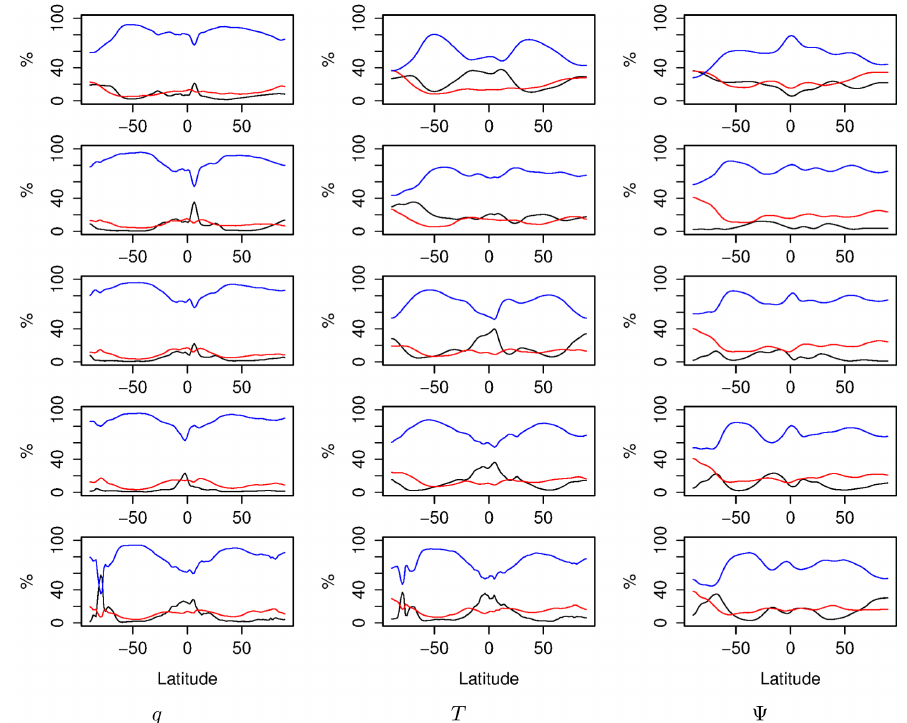
Figure 4. Decomposition of the zonal mean square correction term for December corrections. Statistics are computed for 200hPa layers as in Fig. 2. Black lines represent the squared mean term, red lines the interannual variance, and blue lines the intra-month